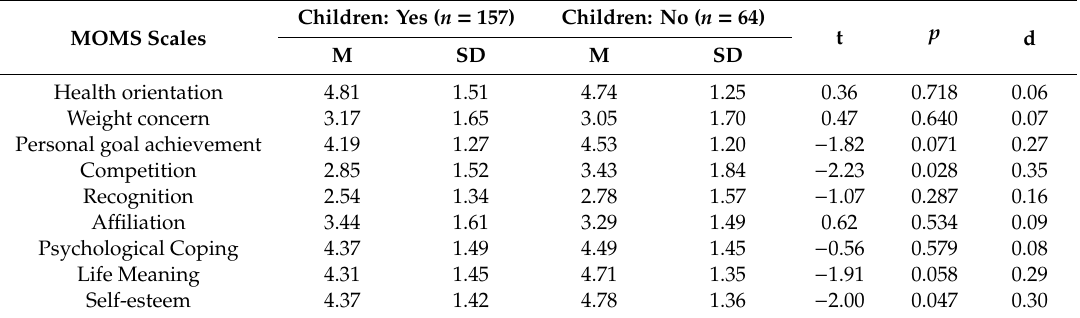
Table 6. Runners in marriage / relationship having children vs. runners in marriage / relationship not having